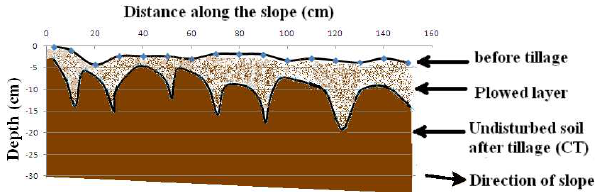
Figure 5. Typical p rofiles of soil before and after the application of conservation tillage (CT). The rugged profile of the undisturbed soil beneath the plowed layer creates fill and spill type of subsurface flow. In contrast, traditional cross plowing results in sharp horizontal profile of furrow bottoms that are laid along the slope, at about 10 cm depth, thus leading to increased flow momentum and soil erosion.